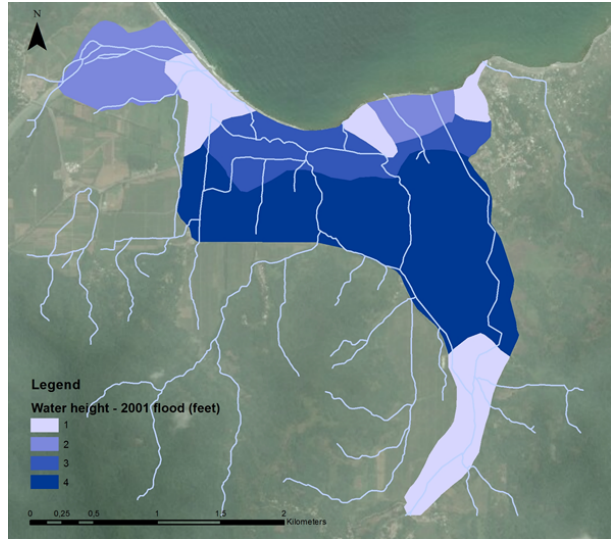
Figure 2. Flood extent of 2001 inundations caused by Tropical Storm Michelle in Annotto Bay, Jamaica (Glas et al.,